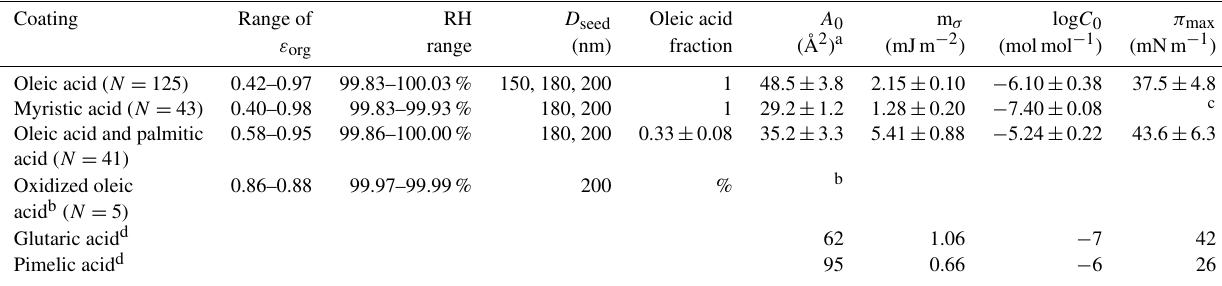
Table 1. Summary of experiments and corresponding compressed film model fit parameters. Coating Range